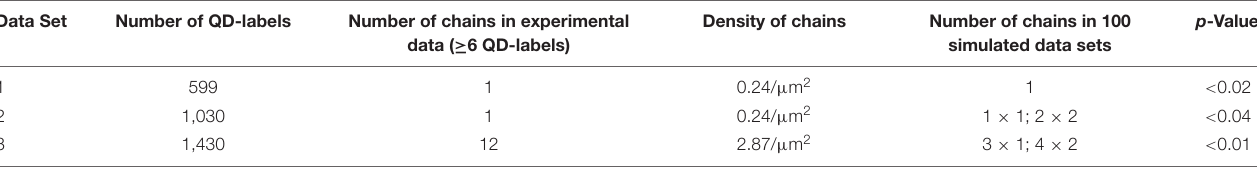
TABLE 2 | Comparison of experimental and simulated random data of linear QD-chains on cancer cells. Data Set Number of